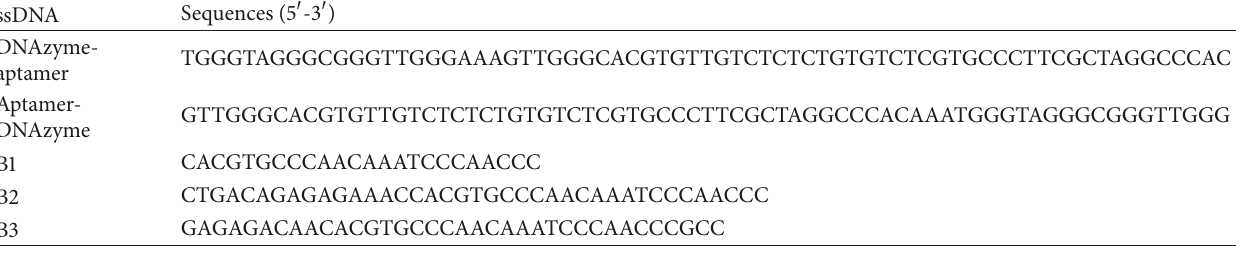
Table 1: Sequences of oligonucleotides used in this study. ssDNA: single stranded DNA; B: blocker complementary sequence. ssDNA